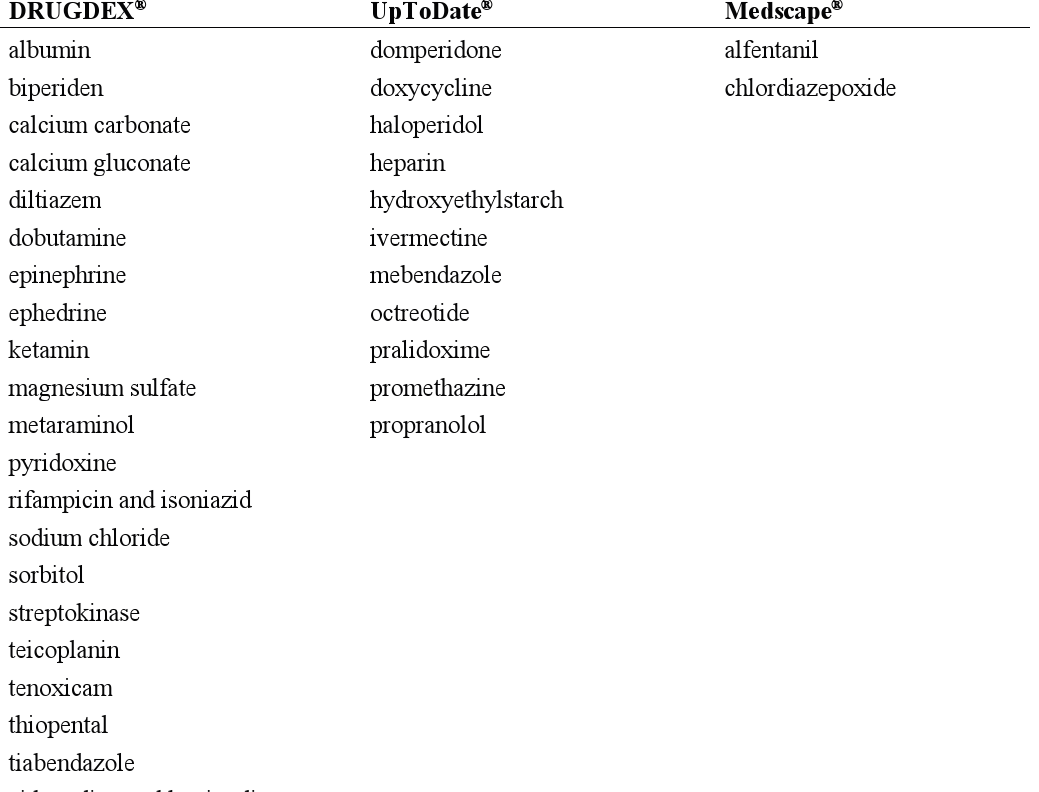
Table 1. Drugs classified as nephrotoxic in only one of the international databases out of a total of 218 drugs that were evaluated.